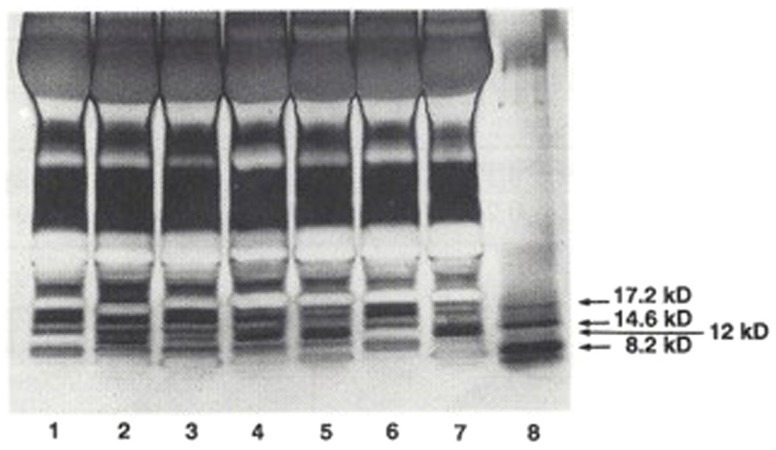
SDS-PAGE separation of protein bands from plasma from hypertensives and normotensives. Bands were stained with silver nitrate. Myoglobin protein markers of 17.2, 14.6, and 8.2 kDa molecular weight and the locus of the 12 kDa protein are shown in Lane 8. Lane 1: Normotensive control. Lanes 2 and 3: normotensives with family history of hypertension. Lanes 4 and 5: hypertensives. Lane 6: normotensive control. Lane 7: hyperaldosteronism. Plasma samples applied in lanes 2 and 3 were obtained from the two individuals shown to possess elevated levels of HMW Na-K-ATPase inhibitor. From Ref. (9) with permission from the editors.